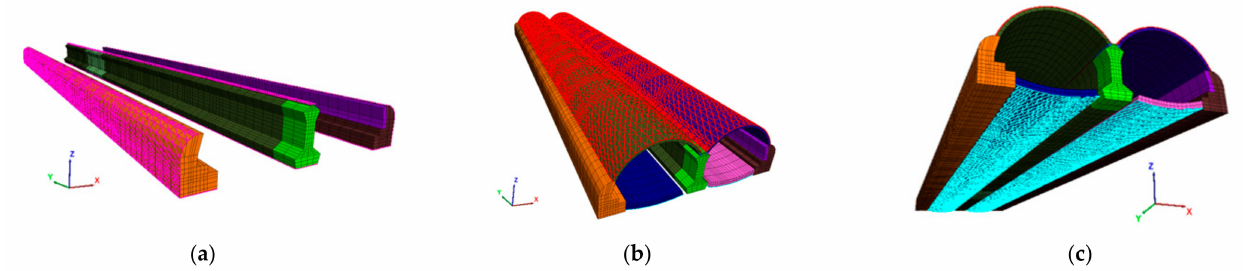
Figure 4. The contact surface: ( a ) The contact surface between the pilot tunnel and the partition wall; ( b ) The contact surface between the lining and surrounding rock; and ( c ) The contact surface between the inverted arch and surrounding rock.